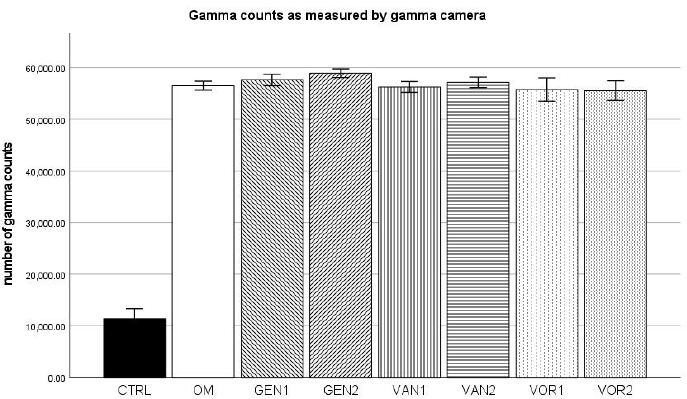
Figure 11. Mean 99m technetium uptake per group as measured by activimeter, normed for 10,000 cells. The error bars show the error of mean. Significances are indicated by stars: bold stars indicate a significance compared to the negative control CTRL, stars in italics indicate a significance compare to the osteogenic control OM. *** = significance p ≤ 0.001.